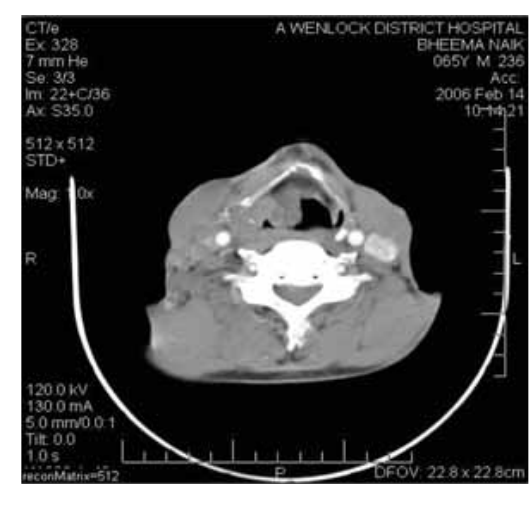
Figure 3. Right pyriform fossa keratinizing SCC extending to the aeryepiglottic fold with invasion of the thyroid cartilage Ipsilateral nodal involvement was observed in the majority of the malignant lesions. The majority of the nodes involved were distributed in the vicinity of the lymph nodal drainage site of the lesions involving